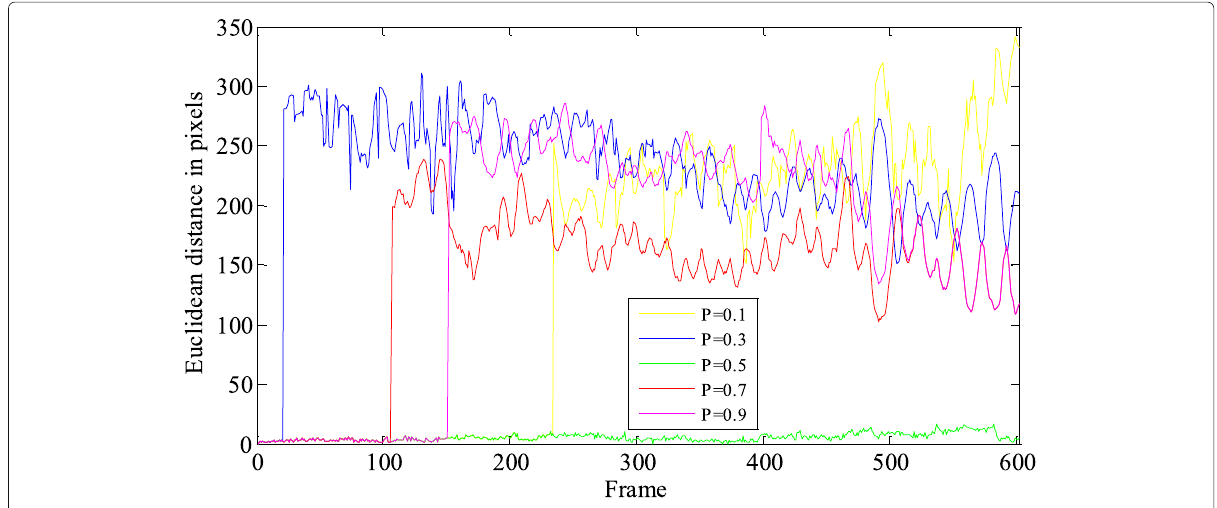
Fig. 7 Tracking accuracy comparisons of different threshold P . P =0.1, 0.3, 0.5, 0.7,